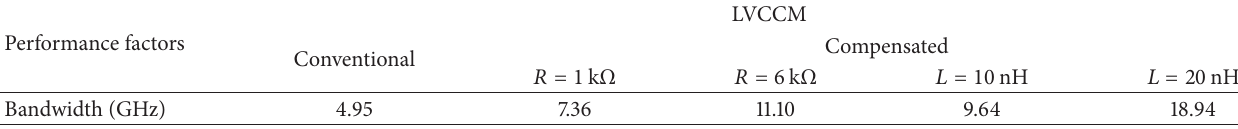
Table 3: Bandwidth comparison of conventional and proposed LVCCM.